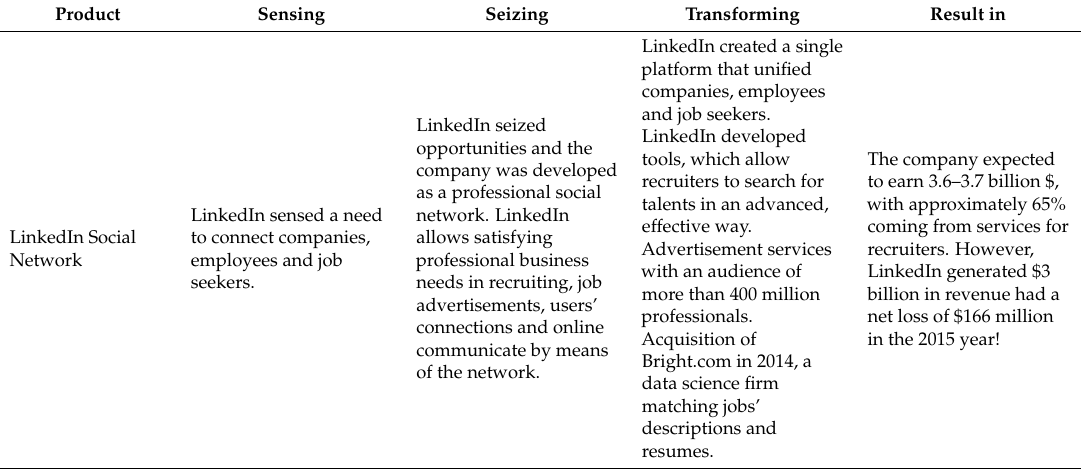
Table 6. Dynamic capabilities at LinkedIn to develop social network before the acquisition by